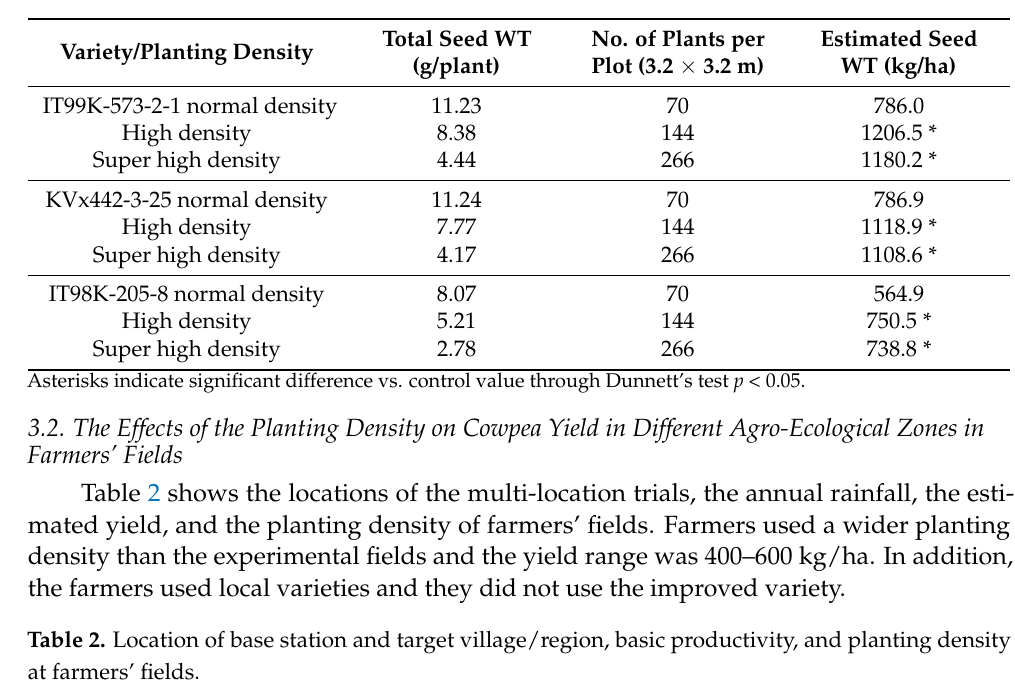
Table 1. Total seed weight per plant with different planting densities.